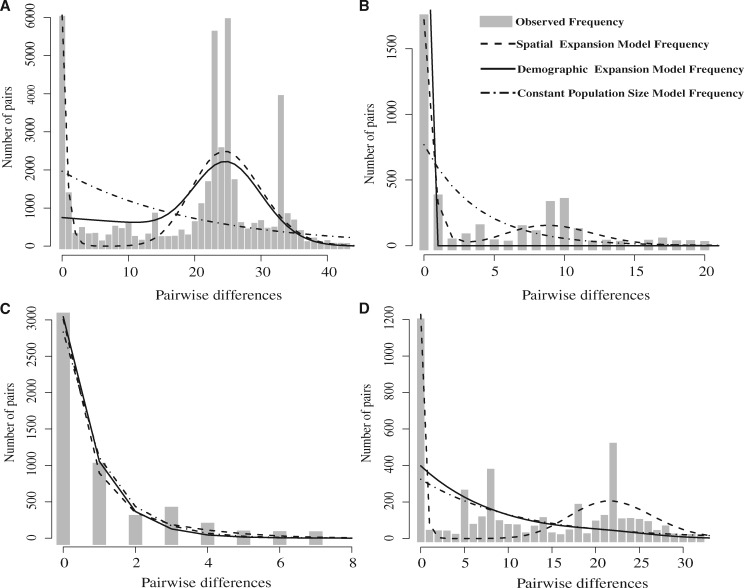
—Mismatch distributions of symbiotic genes. Frequency distributions of observed pairwise nucleotide differences in concatenated symbiotic genes based on multilocus sequence typing (gray bars), with expected distributions modeled under three different demographic scenarios (black lines). (A) All pairwise comparisons; (B) Clade I only; (C) Clade II only; and (D) Clade III only.